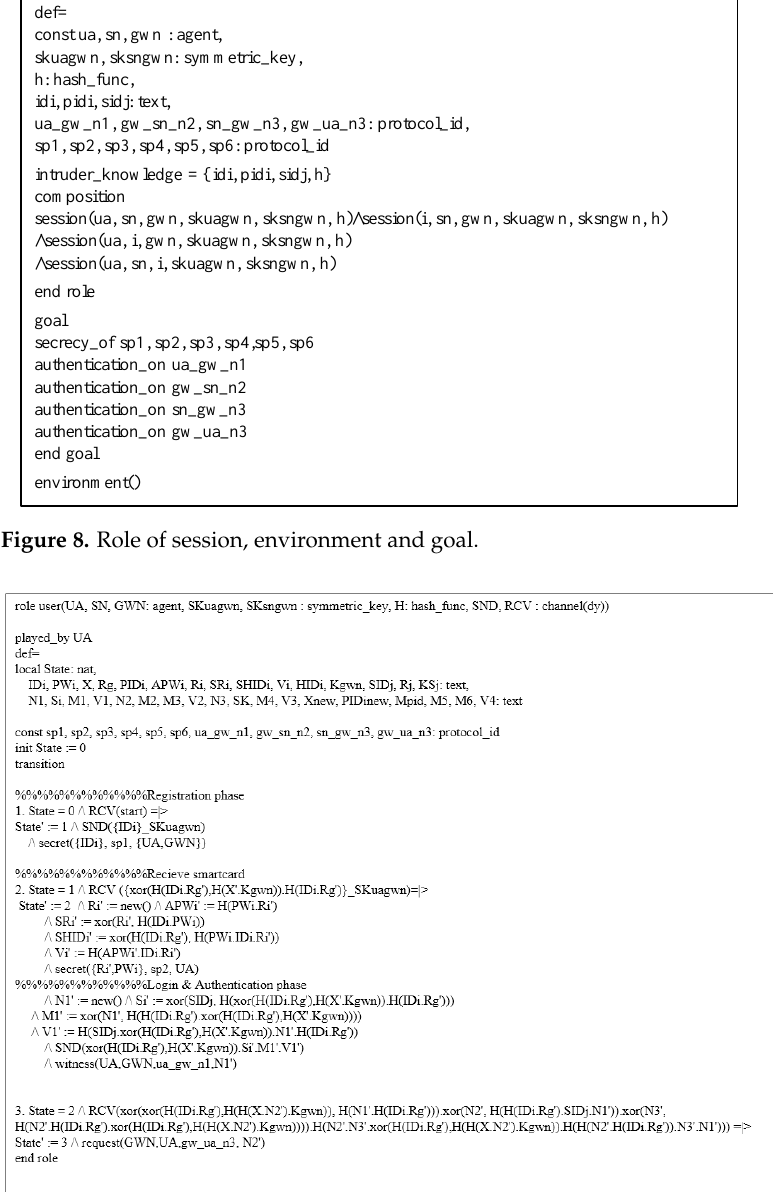
Figure 9. Role of